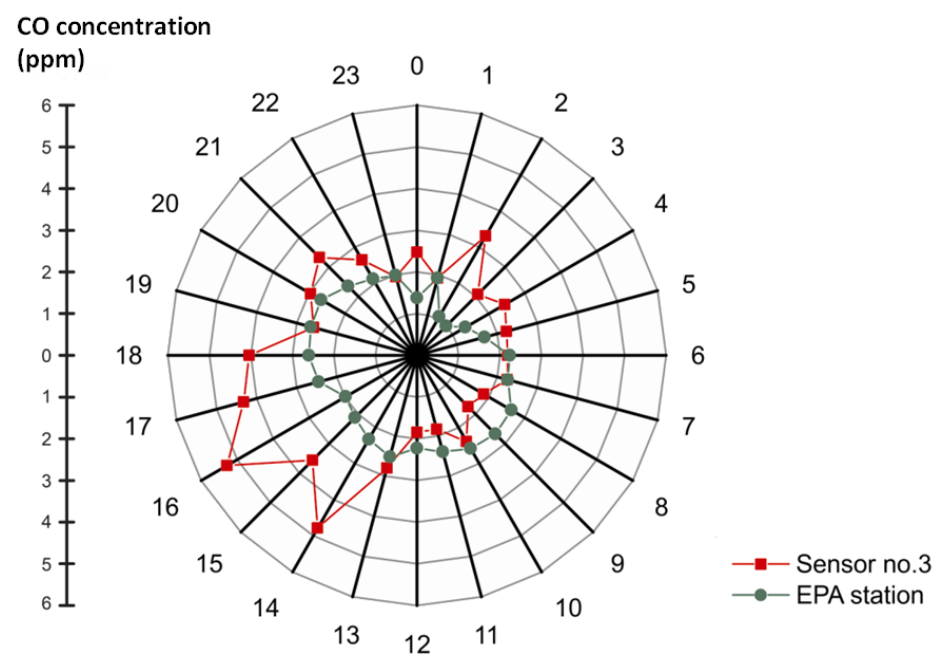
Figure 7. Comparisons of hourly average CO concentration between Sensor No.3 and the EPA station over different time of a day from July to September